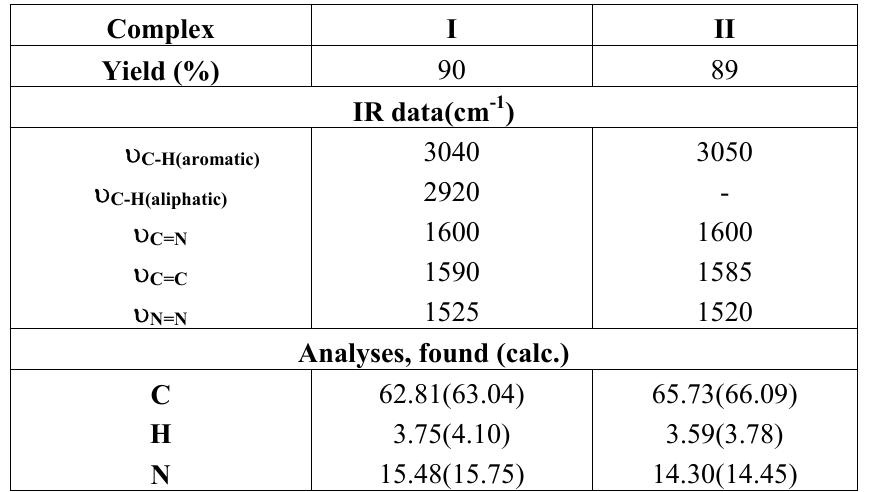
Table 1 Characterization data for complexes I and